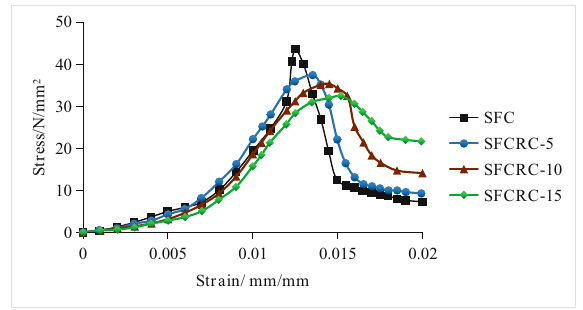
Figure 12: Stress – strain curve of